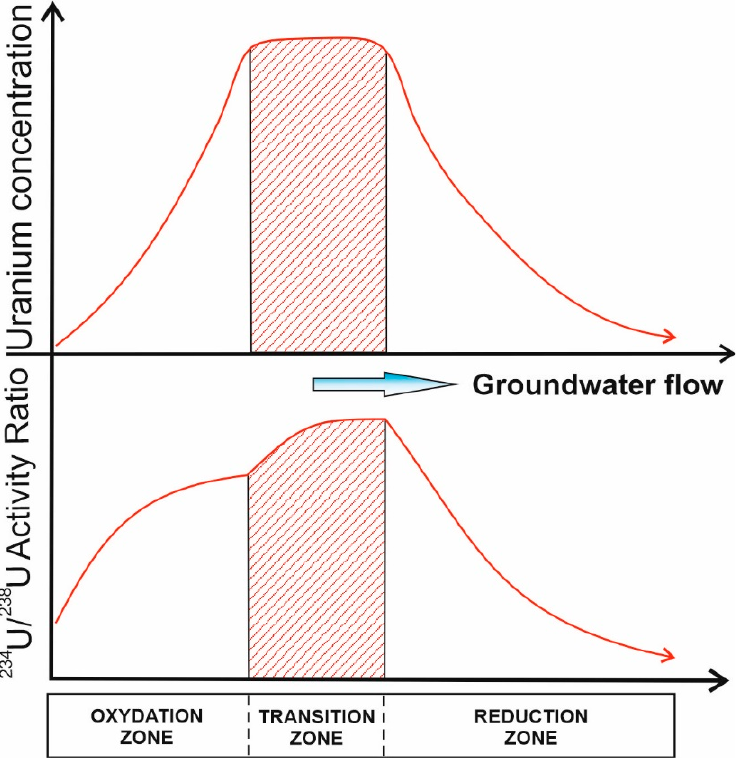
Figure 1. Variation in Uranium Concentration and 234 U/ 238 U Isotope Ratio in the Oxidation, Transi- tion and Reduction Zones of an Aquifer [4] (Redrawn).